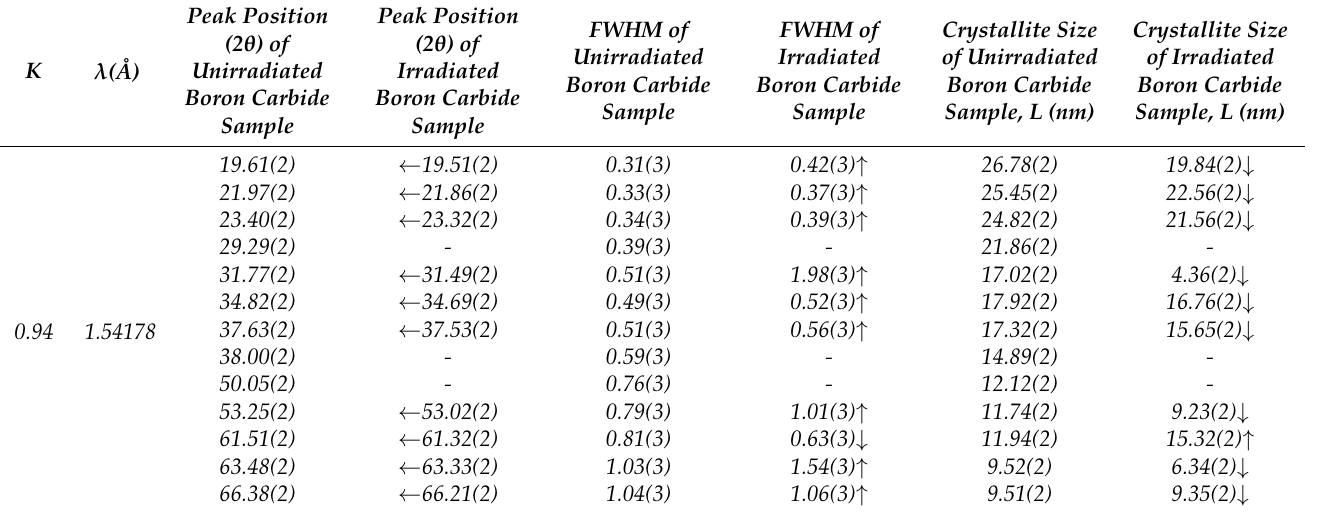
Table 1. Crystallite size of the unirradiated and irradiated B 4 C boron carbide sample under 167 MeV energy 132 Xe 26+ SHIs at 3.83 × 10 14 ion/cm 2